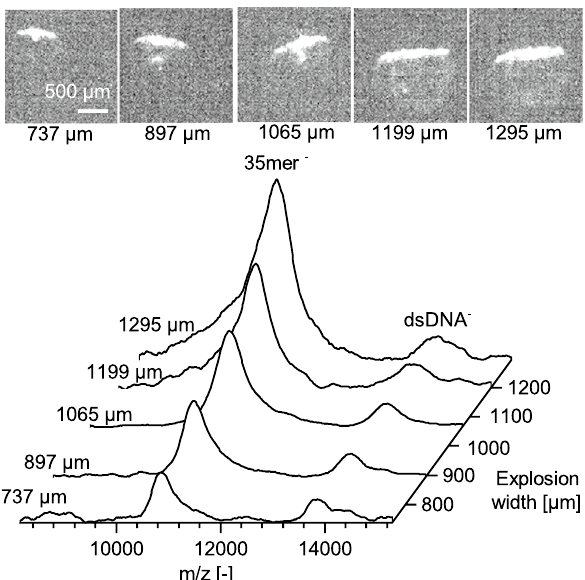
Figure 2. LILBID spectra of five droplets with different explosion widths. Top: Images of the corresponding droplets taken 5 µs after IR irradiation. Image contrast was enhanced for better visualization. Bottom: Spectra showing increasing dissociation of the 10_Amer + 35_Amer sample with increasing explosion width. Spectra are normalized to the peak height of the dsDNA - peak. For full spectra, see Supplementary Fig. S9. This figure